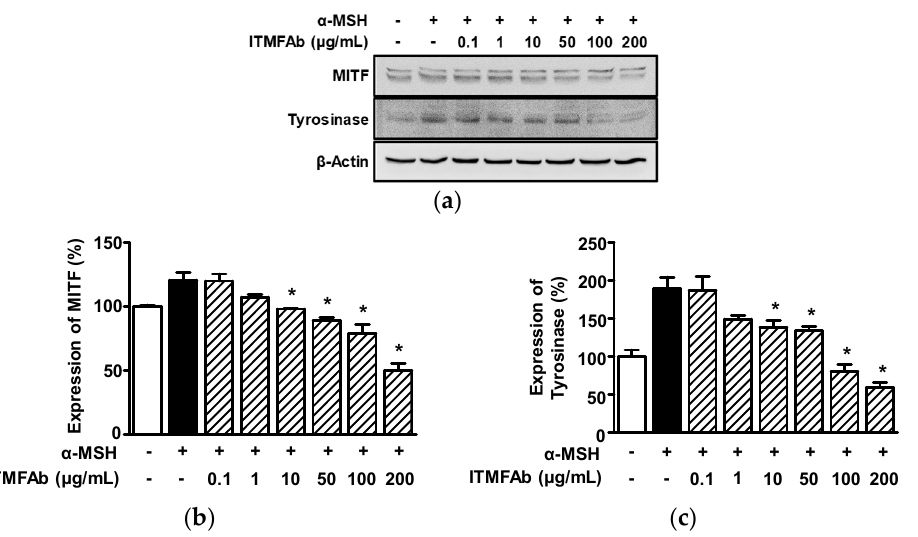
Figure 7. Effects of Impatiens textori Miq. flower absolute on melanogenesis-associated proteins in B16BL6 melanoma cells. ( a ) Representative images. B16BL6 melanoma cells were pretreated with DMEM (containing 2% FBS) in the presence or absence of α -MSH (200 nM) for 10 min or incubated with or without α -MSH (200 nM) in the presence or absence Impatiens textori Miq. flower absolute (ITMFAb; 0.1–200 µg/mL) for 5 min. Cell lysates were immunoblotted with the antibodies described